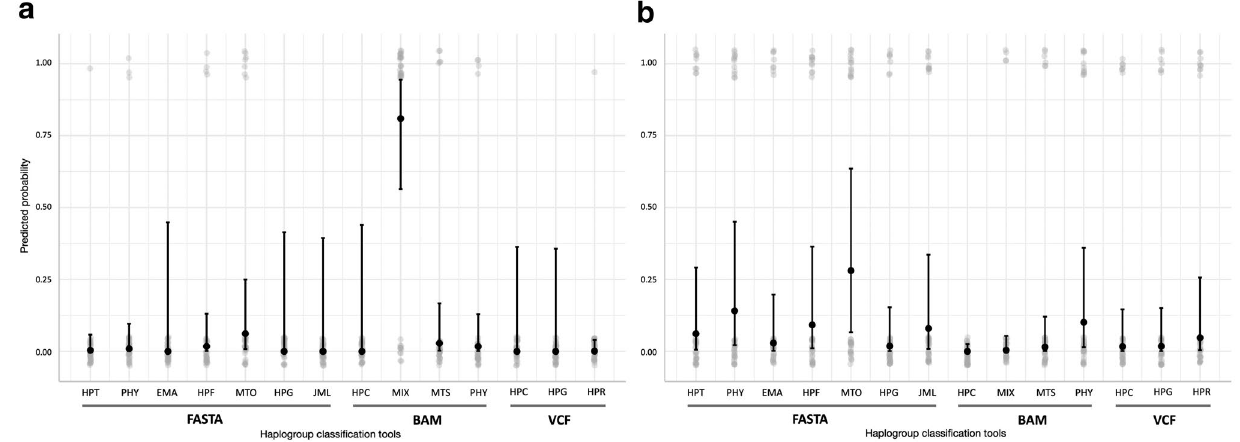
Figure 2. Predicted probability values (and 95% confidence intervals) of the GLMM model estimated for each tool for ( a ) WGS and ( b ) WES datasets. In light grey, the raw data from the haplogroup